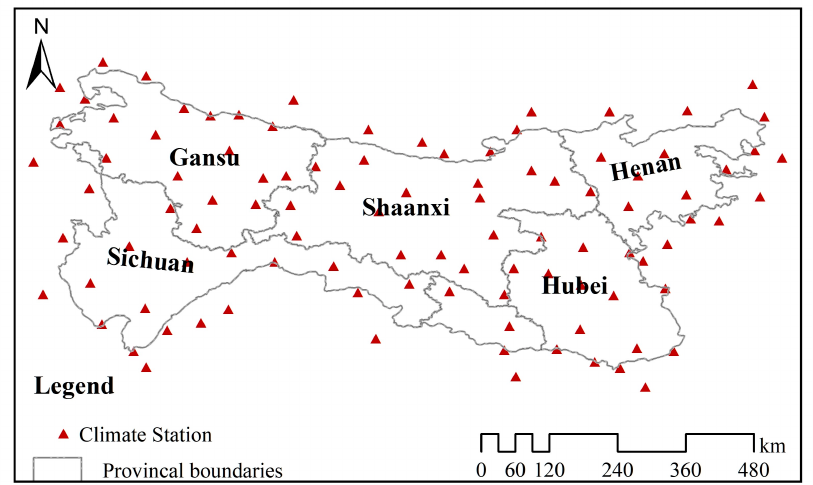
Figure 2. Spatial Distribution of Selected Meteorological Stations in the Study Area.